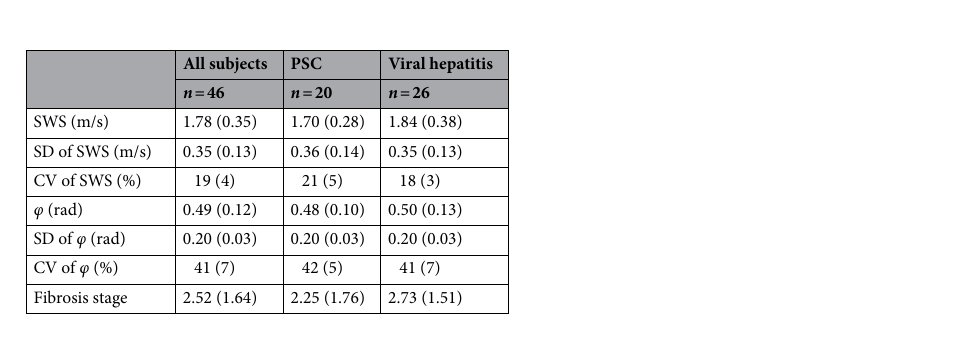
Table 2. MRE results. Data are means and numbers in parentheses are standard deviations. SWS shear-wave speed, SD standard deviation, CV coefficient of variation, φ phase angle of the complex shear modulus.